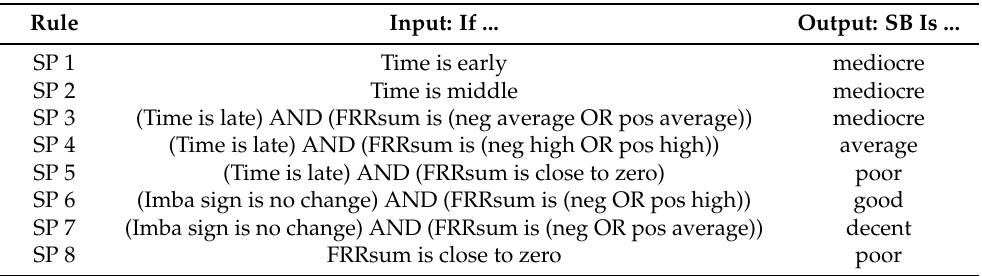
Table A3. Overview of fuzzy logic rule set for single pricing (DE). Rule Input: If ... Output: SB Is ...